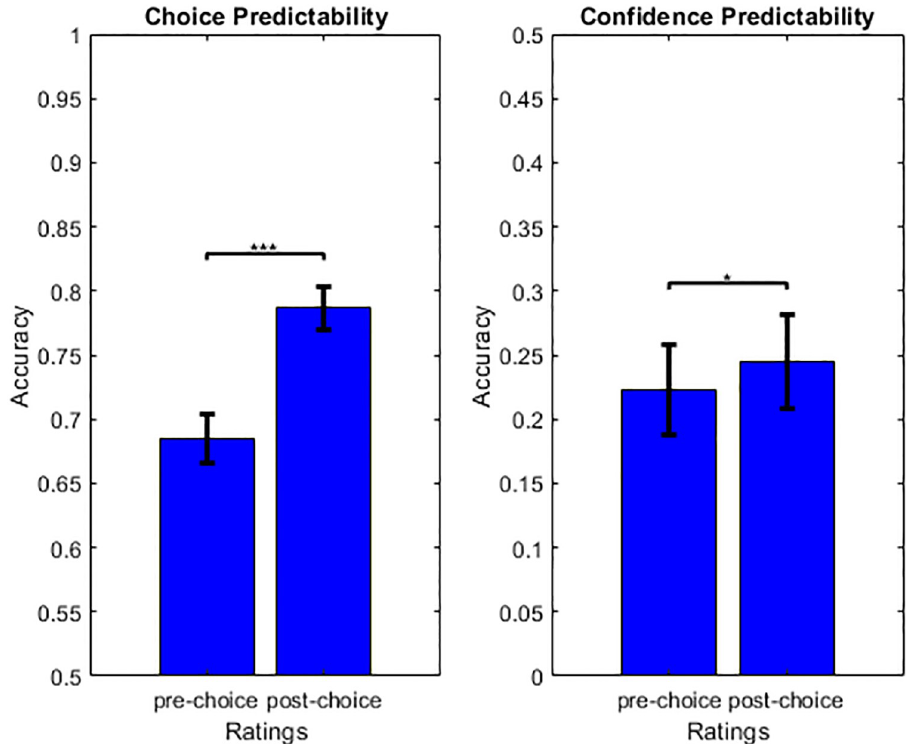
Fig 4. Prediction accuracy of choice and choice confidence. Left: Mean choice prediction accuracy is plotted for pre- choice (left) and post-choice (right) value ratings. Right: Mean choice confidence prediction accuracy is plotted for pre-choice (left) versus post-choice (right) value and value uncertainty ratings. Error bars depict 95% confidence intervals.